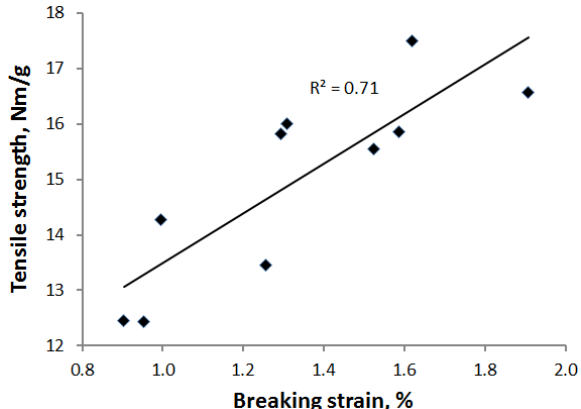
Figure 9. Correlation between strength and breaking strain for the calendered sheets obtained with the various drying